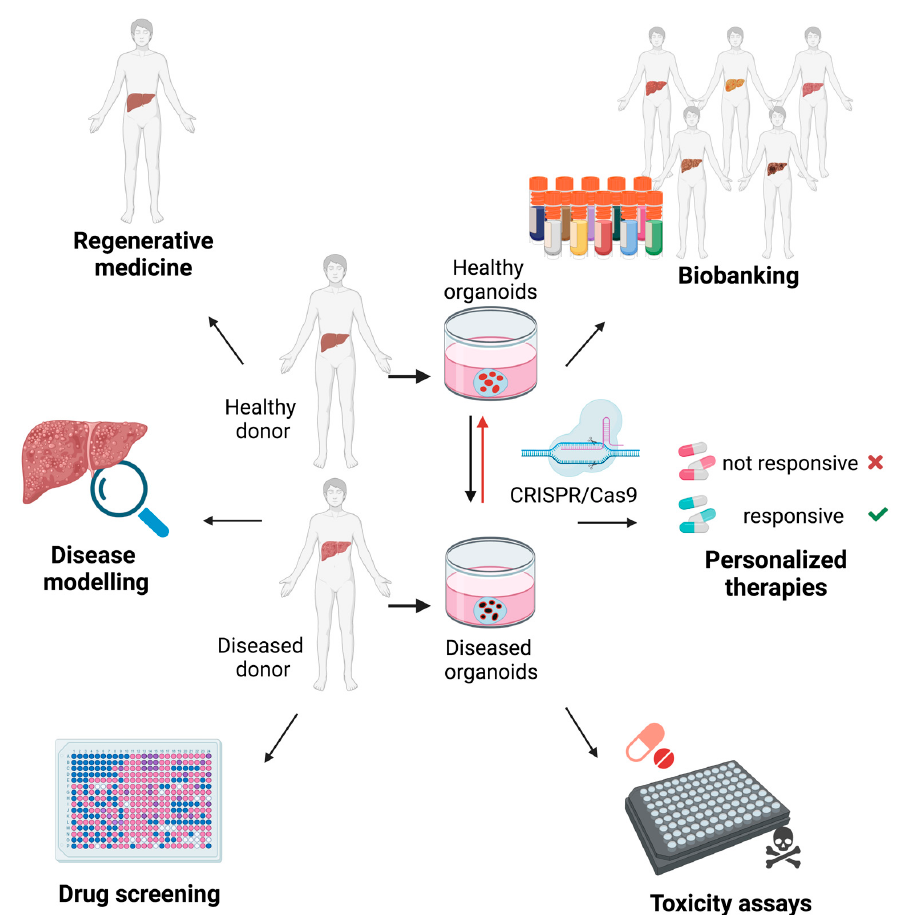
Figure 2. Applications of liver organoids. Healthy and diseased patient-derived organoids represent a precious model to investigate the physiopathology of the liver. Liver organoids harboring mutations for liver diseases studies can be additionally generated by CRISPR/Cas9 gene editing. Liver organoids cover a broad range of biomedical applications including personalized medicine to identify patient-specific responses to drugs. Moreover, cryopreservation enables the establishment of biobanks that can be used for large-scale studies as drug screening, toxicity assays and regenerative medicine.